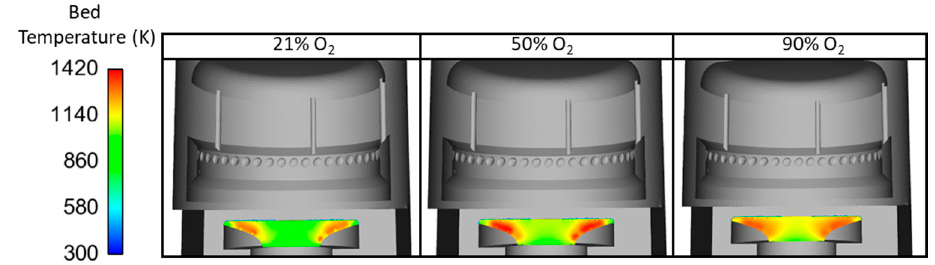
Figure 9. Contours of the packed bed temperature for the simulations of 21%, 50%, and 90% of oxygen in the inlets.